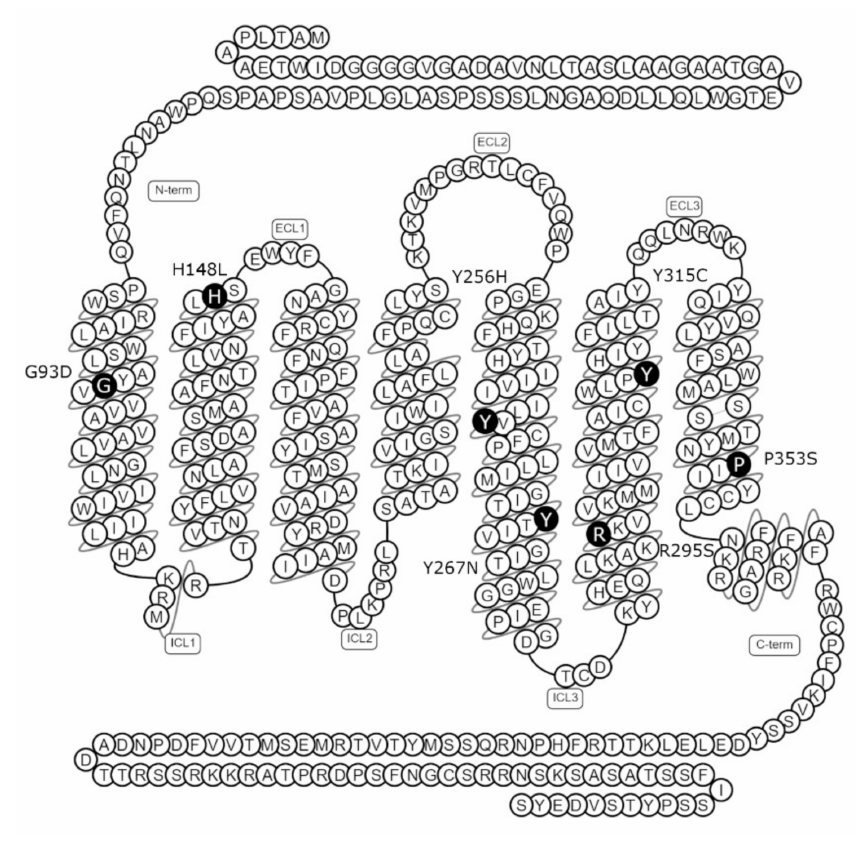
Figure 2. Schematic of the human NK3R amino acid sequence with positions of naturally occurring point mutations identified in patients with congenital hypogonadotropic hypogonadism. Positions of the non-synonymous point mutations considered in this study are indicated by black circles. N-term, N-terminus; ECL, extracellular loop; ICL, intracellular loop; C-term, C-terminus. Image generated using the GPCR database (gpcrdb.org, accessed on 22 March 2022)